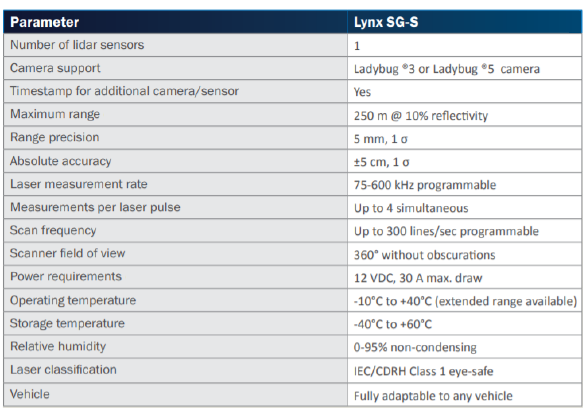
Table 1 . Technical specifications of the dual-head sensor Mobile Laser Scanning (MLS) system Optech Lynx SG adopted for the acquisition of MLS Data Set 1 (source: